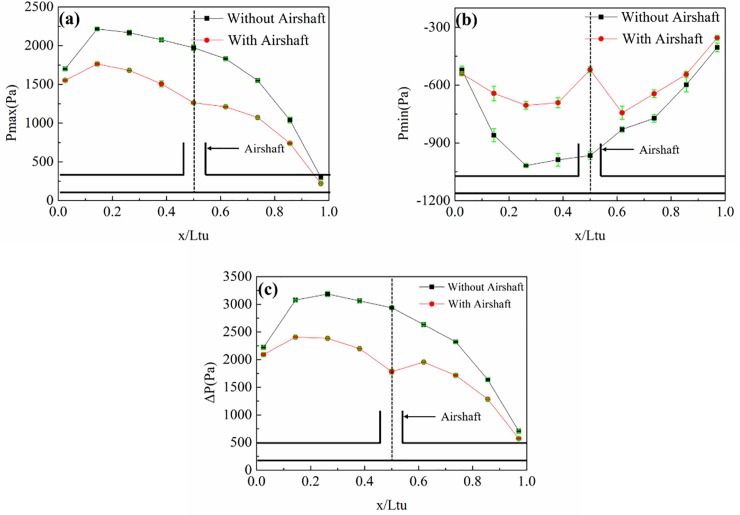
Pressures at different points on the tunnel wall with and without an airshaft.(a), (b), and (c) show Pmax, Pmin, and ΔP respectively.